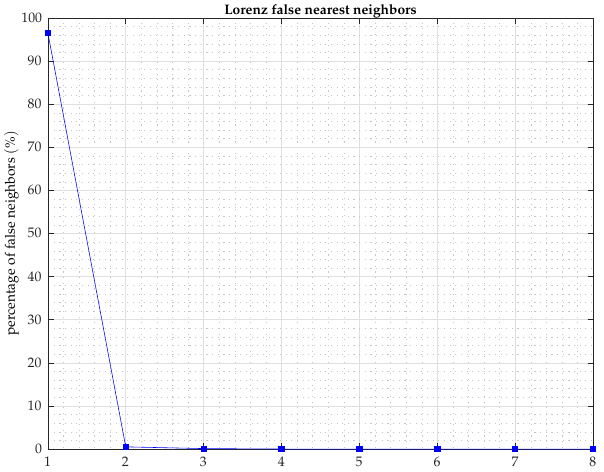
Figure 9. From the dynamic variable x of the Lorenz attractor: false nearest neighbors. From m = 3, the number of false nearest neighbors is almost zero.